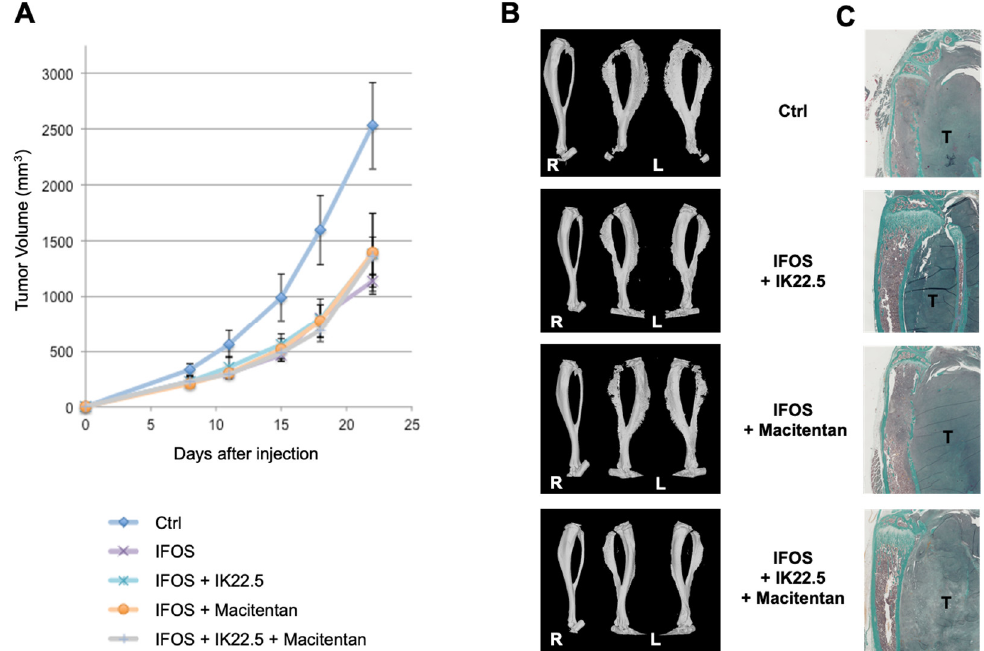
Figure 5. Macitentan and RANKL blocking antibody (IK22.5) injections alone or in combination did not interfere with the chemotherapeutic effect of ifosfamide, and combining them retained the major bone protective effect. Injections of a suboptimal dose of ifosfamide significantly reduced tumor growth in the MOS-J/PG1 mouse model of osteosarcoma ( A ). IK22.5 and macitentan treatment alone or in combination did not interfere with ifosfamide ( A ) but the combination still had a bone protective effect as seen in the micro-CT ( B ) and histological ( C ) views. R: right tibia without tumor; and L: left tibia with tumor; T: tumor.